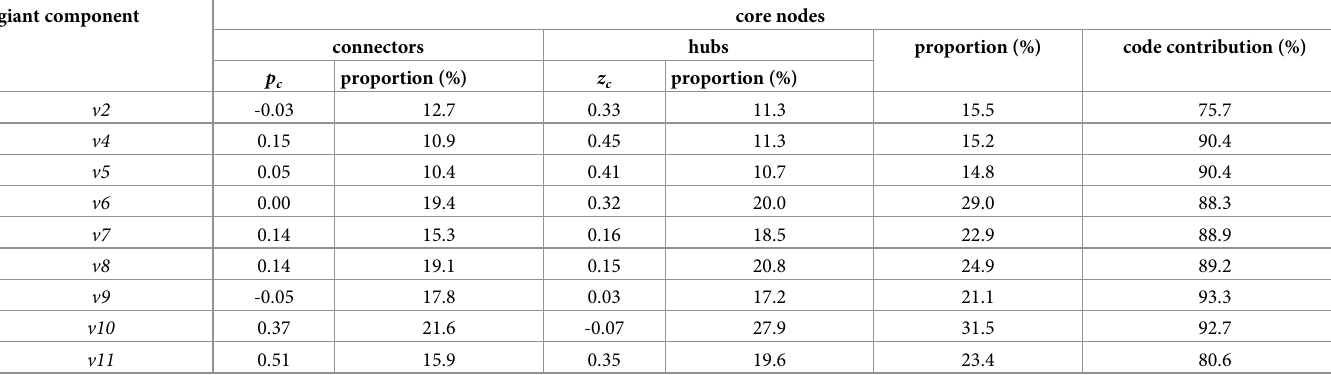
Table 2. Identification of hubs and